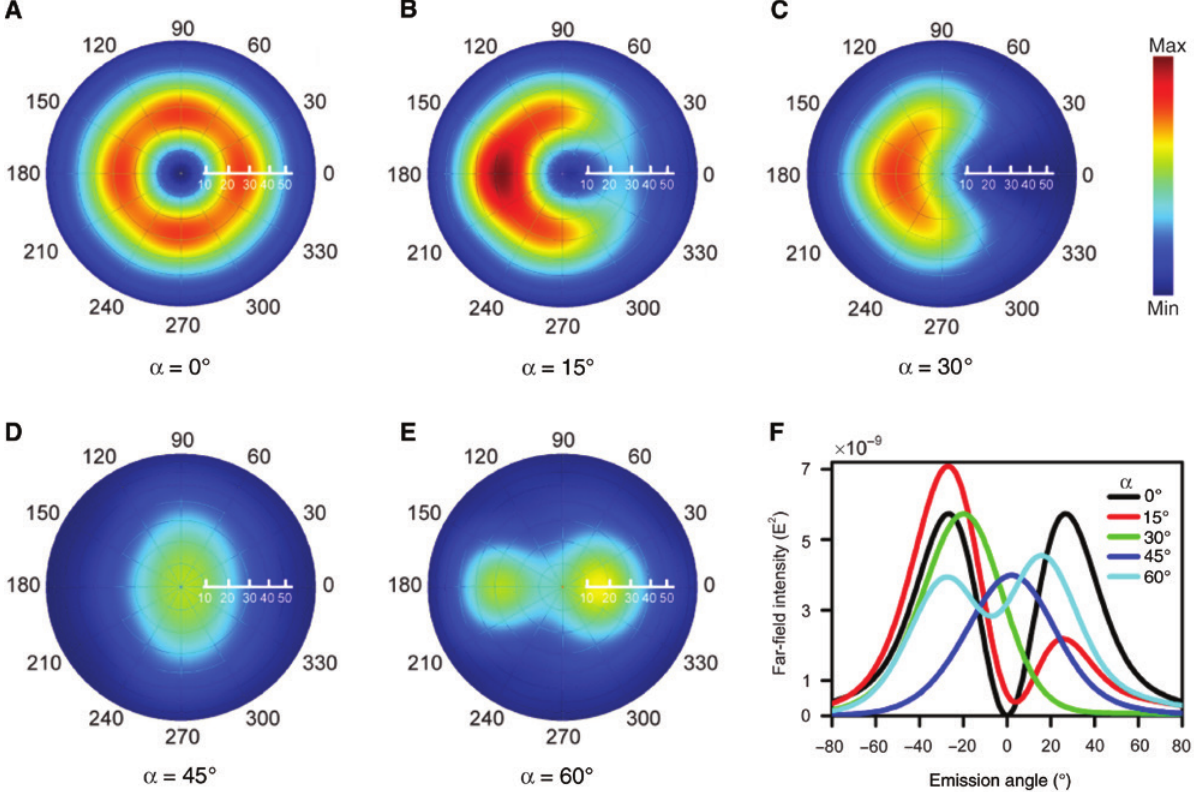
Figure 4: Calculated far-field intensity versus tilt angle of the tip. (A)–(E) The angular distribution patterns of the far-field intensity (|E| 2 ) in the TES system. The far-field intensities are normalized by that of α = 15 ° . (F) The angle-resolved emission pattern of the TES at different tilt angles of the tip ( α